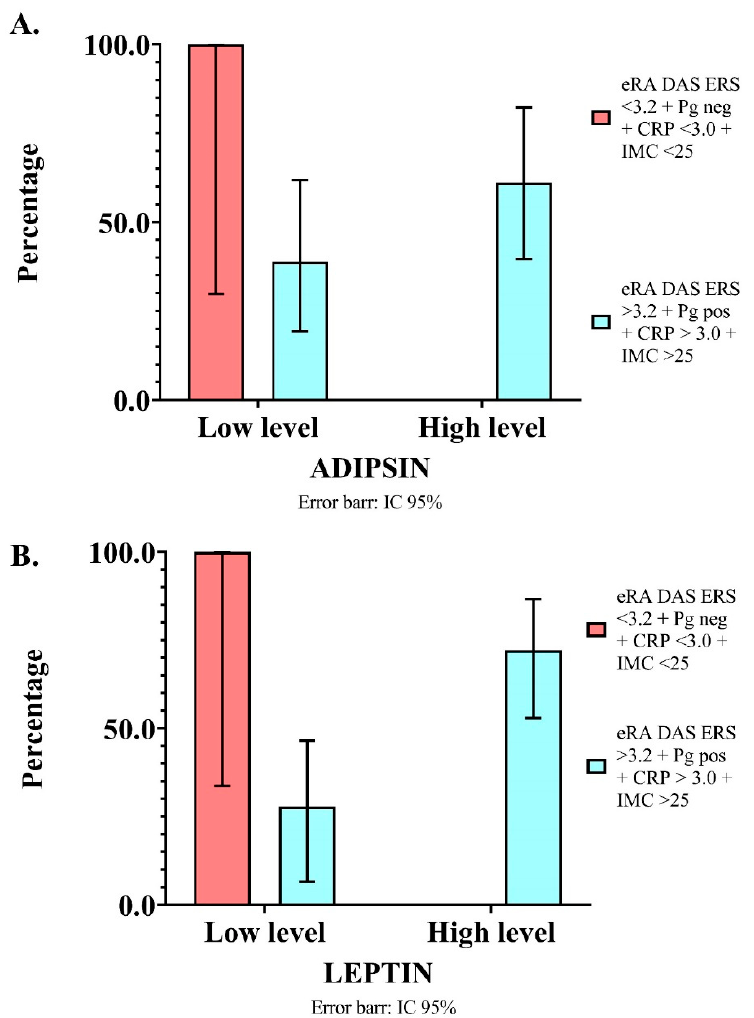
Figure 2. Association between adipokine levels and eRA patients with positive conditions simultaneously: presence of P. gingivalis , BMI > 25, CRP > 3.0 mg/L, and DAS28 ESR > 3.2. ( A ) Leptin levels. ( B ) Adipsin levels. Y axis: frequency of eRA patients with condition. X axis: adipokine levels. BMI: body mass index; CRP: C–reactive protein; Pg : P. gingivalis .